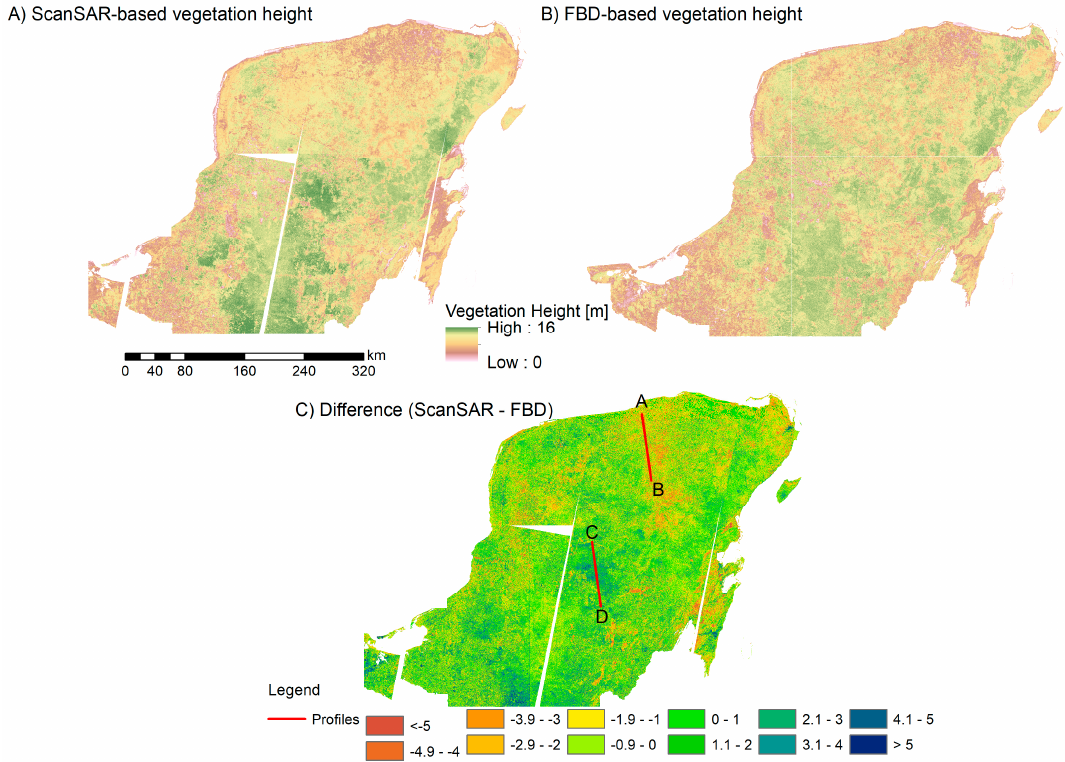
Figure 7. Vegetation height estimates based on ScanSAR ( A ) and FBD ( B ) mosaics using the “spatial sampling” approach. The difference map ( C ) between the two products depicts disagreements in areas with low (northern part) and tall trees (central and southern parts). The height values over the two red transects (A-B profile and C-D profile) are shown in Figure 8. White gaps in the ScanSAR-based vegetation height map resulted from the gaps in the ScanSAR backscatter mosaics.